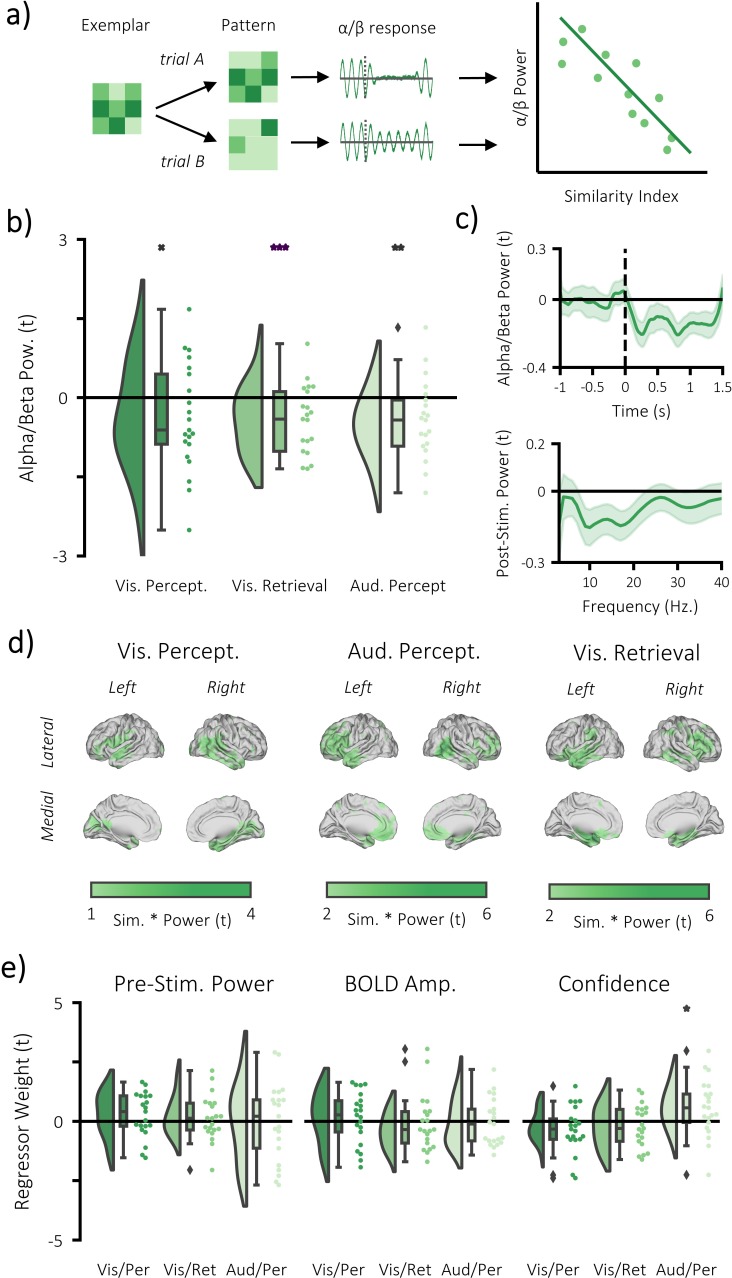
Alpha/beta power decreases track the fidelity of stimulus-specific information.(a) infographic depicting hypotheses and analytical approach. We anticipated that the more a pattern represented matching stimuli relative to differing stimuli, the greater the post-stimulus decrease in alpha/beta power would be. (b) Raincloud plot displaying the correlation between alpha/beta power and stimulus-specific information during visual perception, visual memory retrieval and auditory perception (each dot represents a single participant; xp = 0.054, **p<0.01, ***p<0.001). (c) temporal (top) and spectral (bottom) specificity of the correlation between stimulus-specific information and alpha/beta power across all tasks (see Figure 4—figure supplement 2 for each task individually). A value below zero indicates a negative correlation between variables. The negative relationship becomes apparent after stimulus onset (time = 0) within the frequency range 8–30 Hz. (d) brain map of the correlation between alpha/beta power at each virtual electrode with the measure of stimulus-specific information during visual perception, auditory perception and visual retrieval. (e) Raincloud plot displaying the correlation between stimulus-specific information and additional regressors ‘pre-stimulus alpha/beta power’, ‘BOLD amplitude’, and ‘confidence rating’ for each task (each dot represents a single participant; *p<0.05).